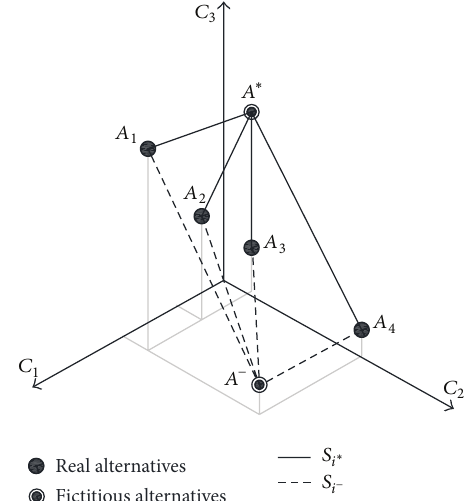
Figure 2: An example of the graphical representation of a decision- making problem according to